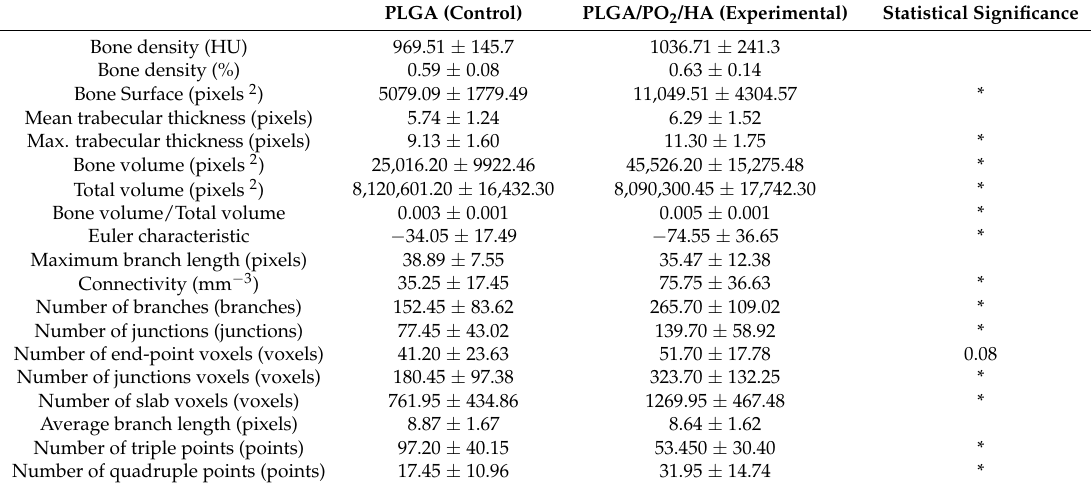
Table 3. Bone J analysis plugins. (* p ≤ 0.05).